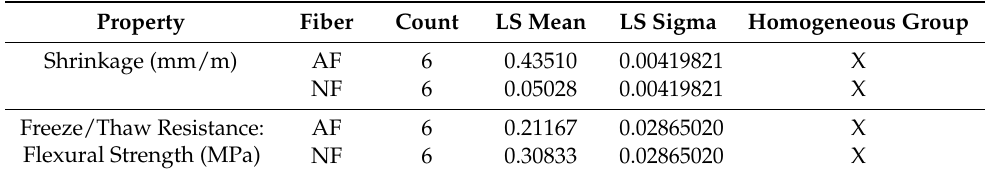
Table 17. Multi-range test for shrinkage and flexural strength considering the incorporation of aramid